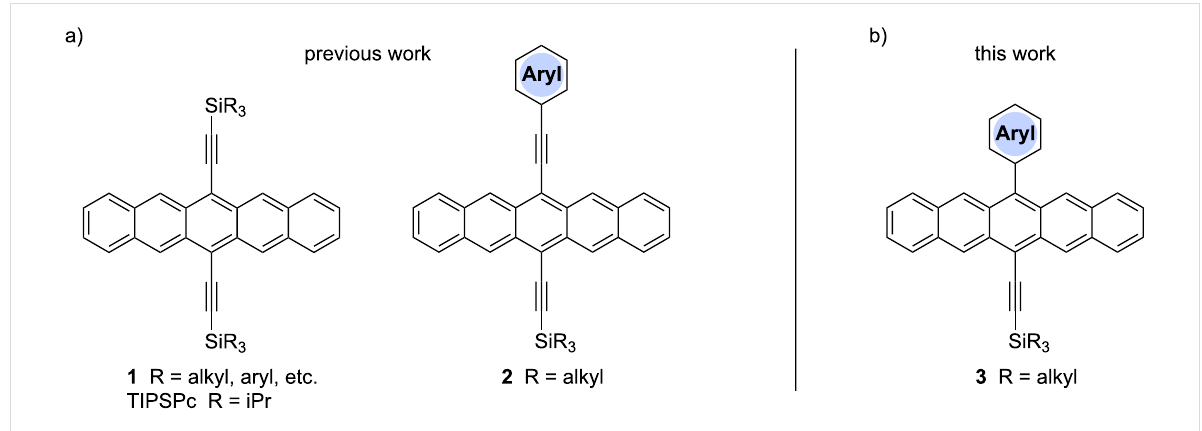
Figure 1: a) Examples of common pentacene functionalization patterns and b) unsymmetrically aryl-substituted pentacenes reported in this